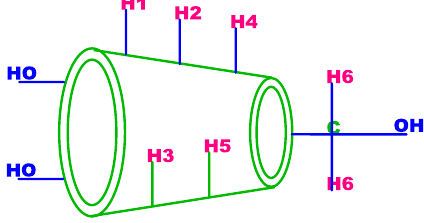
Figure 4. Truncated conical structure of β-Cyclodextrin. Table 2. 1 H NMR data of PNB, β-CD and inclusion complex